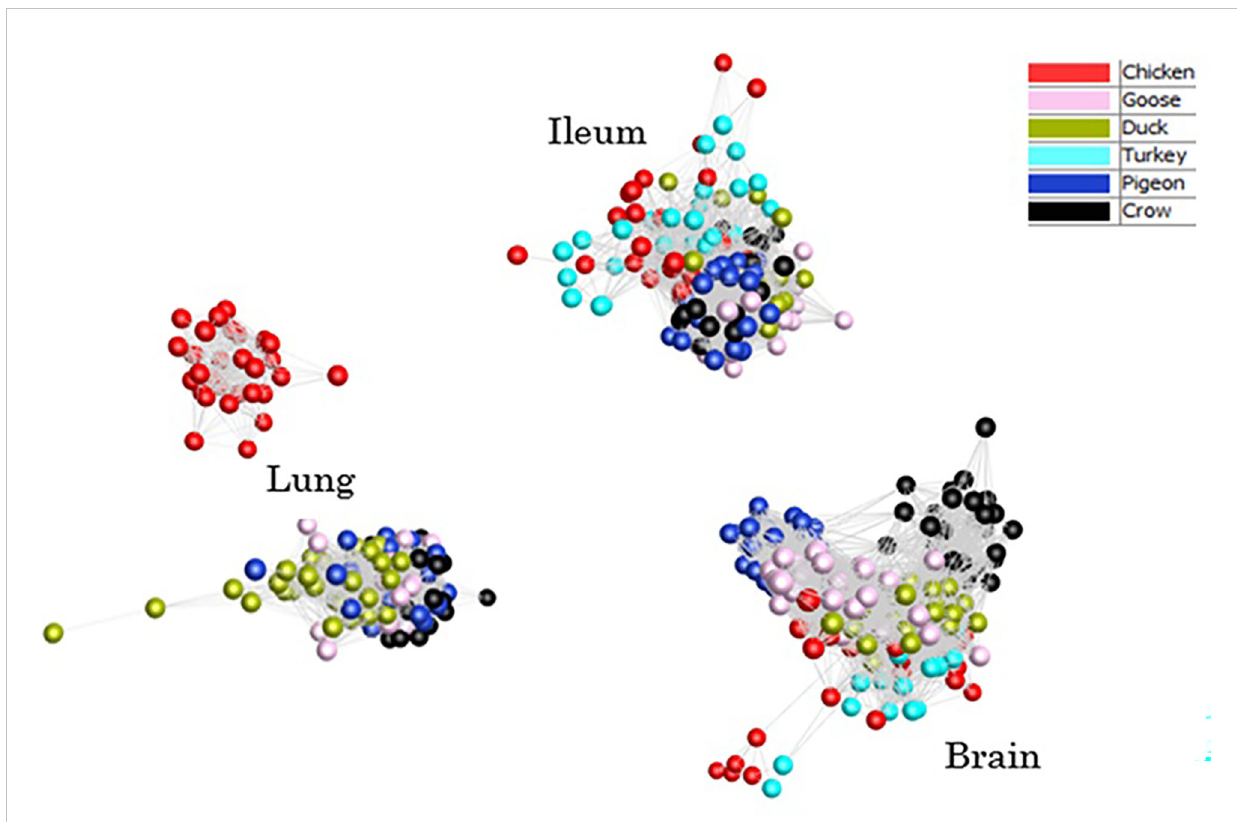
FIGURE 2 Sample-sample network graph of each individual sample normalised counts. Clustering based on Pearson correlations of gene expression in each sample. Colours are based on species with and time points are